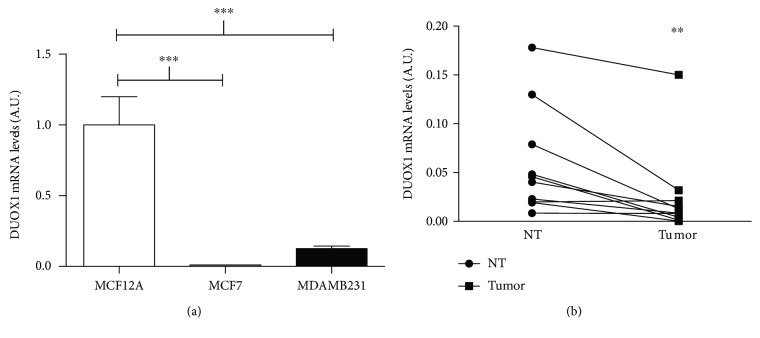
DUOX1 expression is downregulated in breast cancer cell lines and tissues. DUOX1 mRNA levels were evaluated by quantitative RT-PCR in breast cancer cell lines (a) and in paired cancerous and adjacent breast tissue samples (b). Data are expressed as fold change relative to MCF12A for breast cancer cell line comparison and relative to the respective control to breast tissue samples. Results are expressed as mean ± SEM of three independent experiments. ∗∗P < 0.01; ∗∗∗P < 0.001.